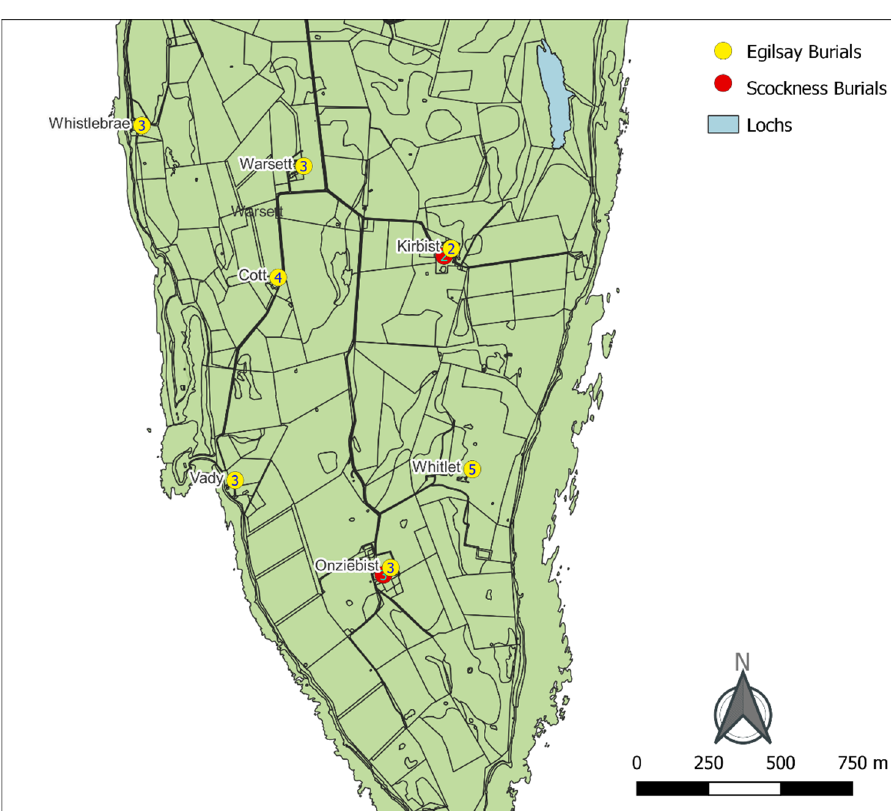
Figure 6. Locations of Onziebist and Kirbist on Egilsay, illustrating variations in burial locations for inhabitants. OS Mastermap © Crown copyright and database rights 2021 Ordnance Survey (100025252).